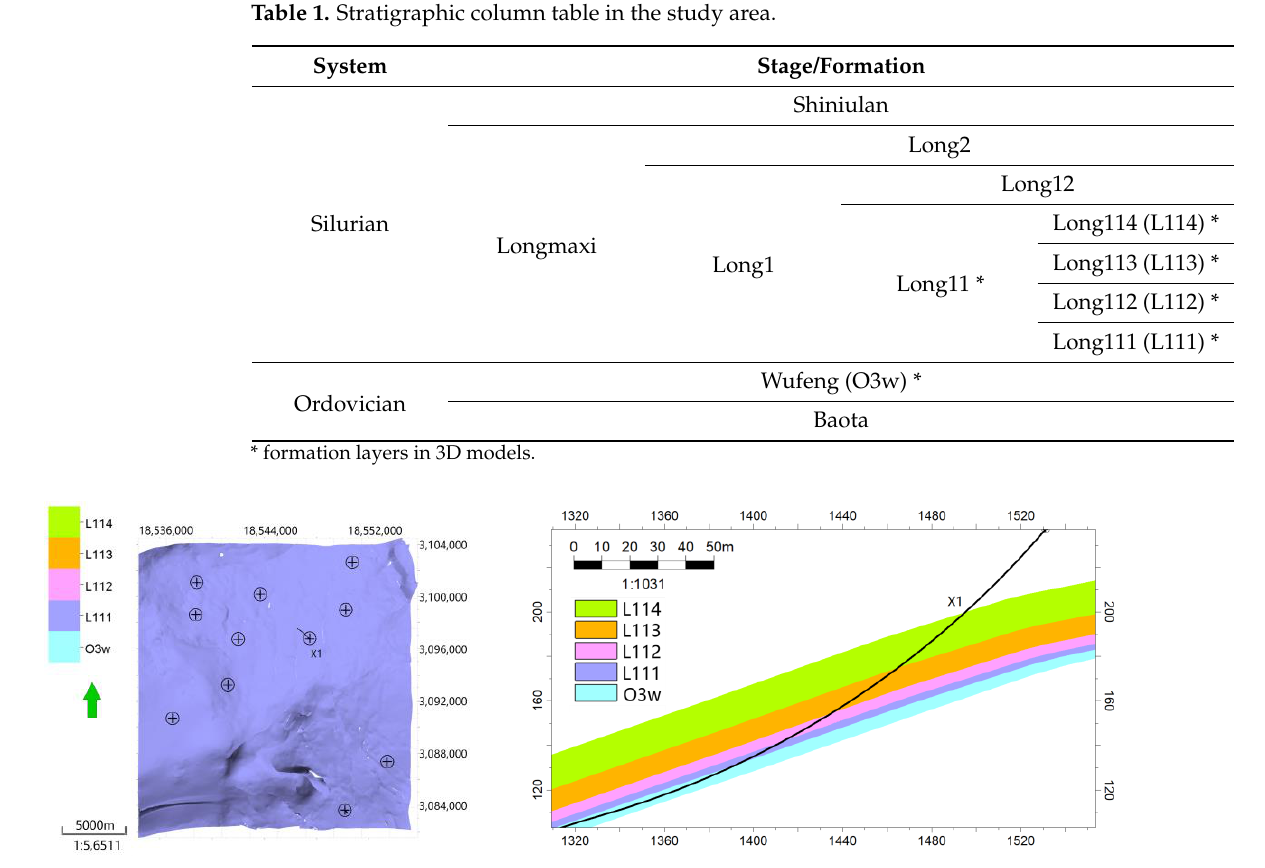
Figure 4. Three-dimensional geological model of the study layer: green layer represents Long 114; orange layer is related to Long 113; pink layer is L112; purple layer connects to L111 and cyan layer are Ordovician Wufeng Formation (the model is visualized by Schlumberger Petrel software).